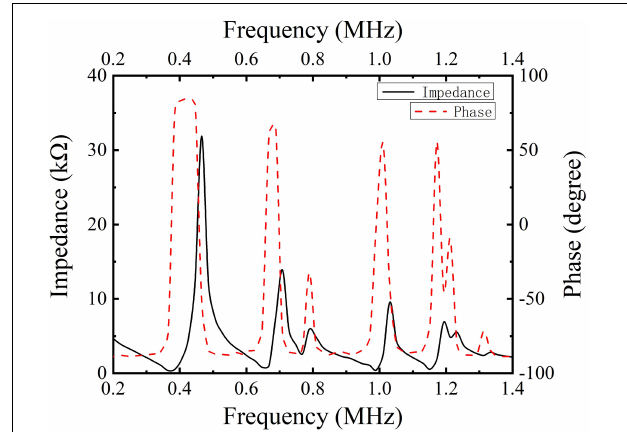
Based on the simulation results, subsequent experiments were carried out. The manufacturing process of the half- concave structure and the structure diagram of the dimpled ultrasonic transducer are shown in Figures 6A,B . As the piezoelectric material, the piezoelectric ceramic pic255